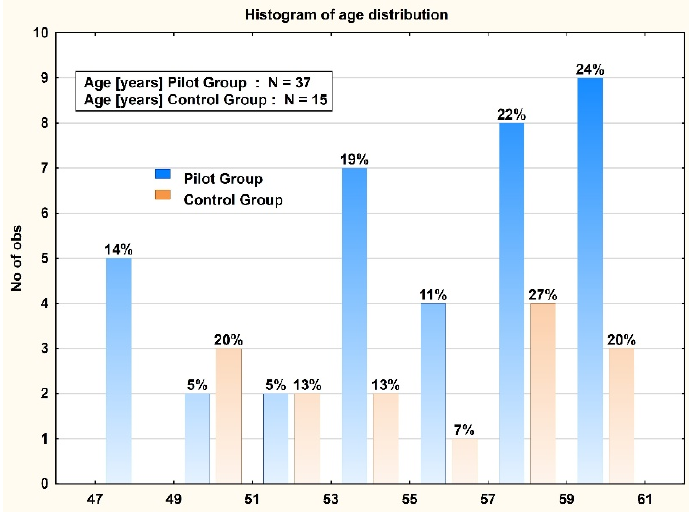
Figure 3. Histogram representation for the age interval distribution of the control group (CG) and the pilot group (PG).